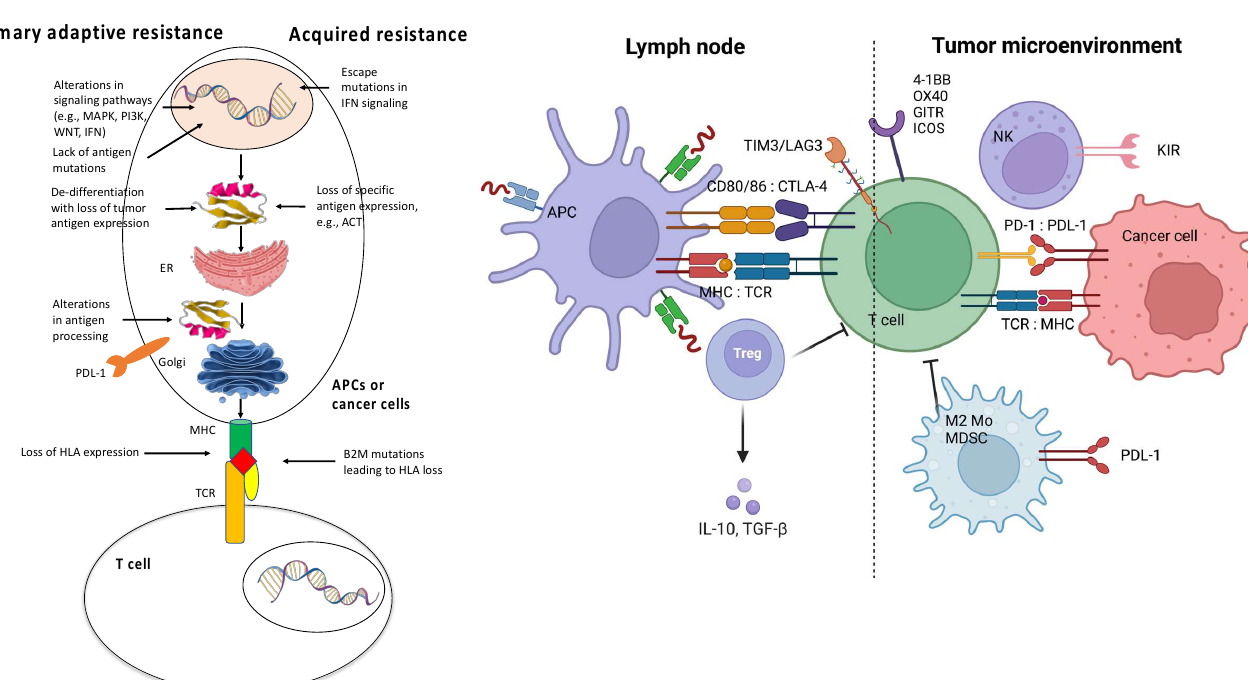
Figure 4. Mechanisms of resistance to immunotherapy. ( A ) Intrinsic mechanisms of resistance to immunotherapy. Examples of intrinsic mechanisms of adaptive resistance involve altered signal- ing pathways, limited mutational burden, de-differentiation of tumor resulting in loss of neoanti- gen expression, defective antigen processing, constitutive PD-L1 expression, and loss of HLA